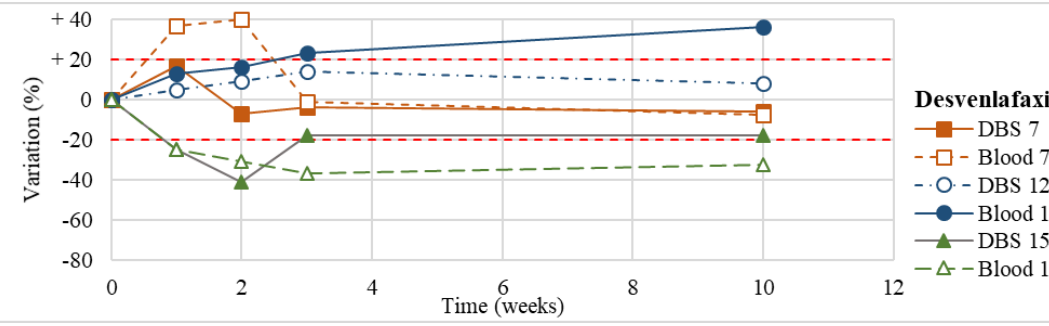
Figure 8. Long-term stability of trazodone ( n = 2) in DBSs stored at room temperature and in blood stored at −20 °C (blood of case n°10 was tested also at T1, T2, T3). Figure 9. Long-term stability of dibenzepin ( n = 1) in DBSs stored at room temperature and in blood stored at −20 °C.